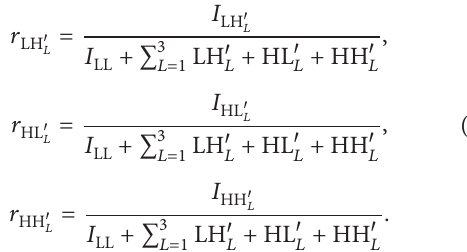
Figure 10: PSNR variation trend with measurement number 𝑀 when using three